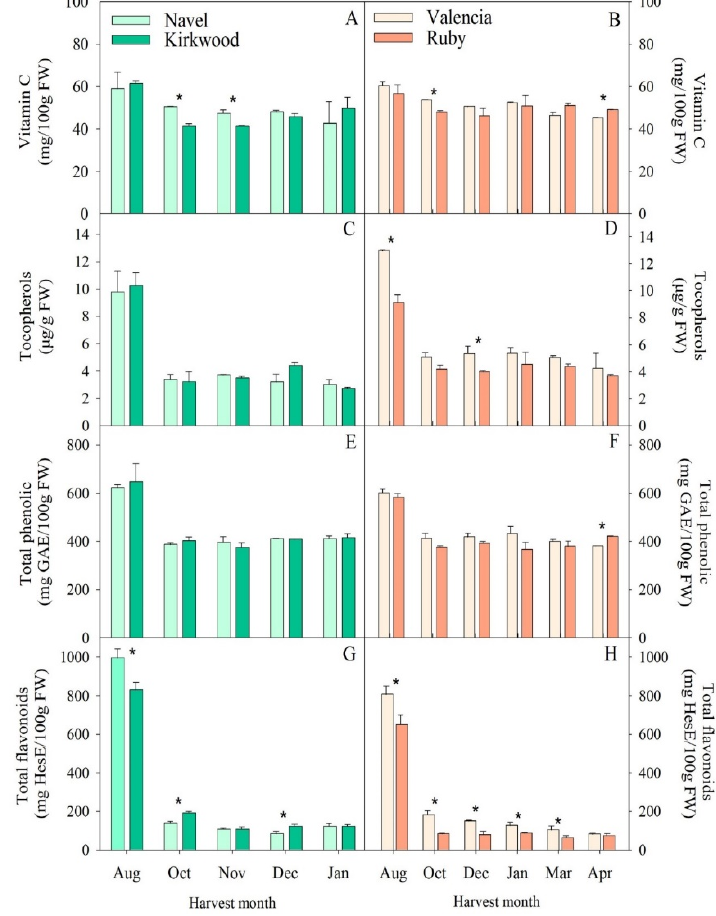
Figure 4. Evolution of vitamin C ( A , B ), tocopherols ( C , D ), total phenolic ( E , F ) and total flavonoid ( G , H ) contents in the pulps of Navel and Kirkwood (left panel) and Valencia and Ruby (right panel) oranges during late fruit development and maturation. Results are the mean of two biological replicates ± SD. Asterisks indicate significant differences between the red-fleshed K and R and the respective ordinary oranges, N and V, for each harvest month by t -test ( p ≤ 0.05).